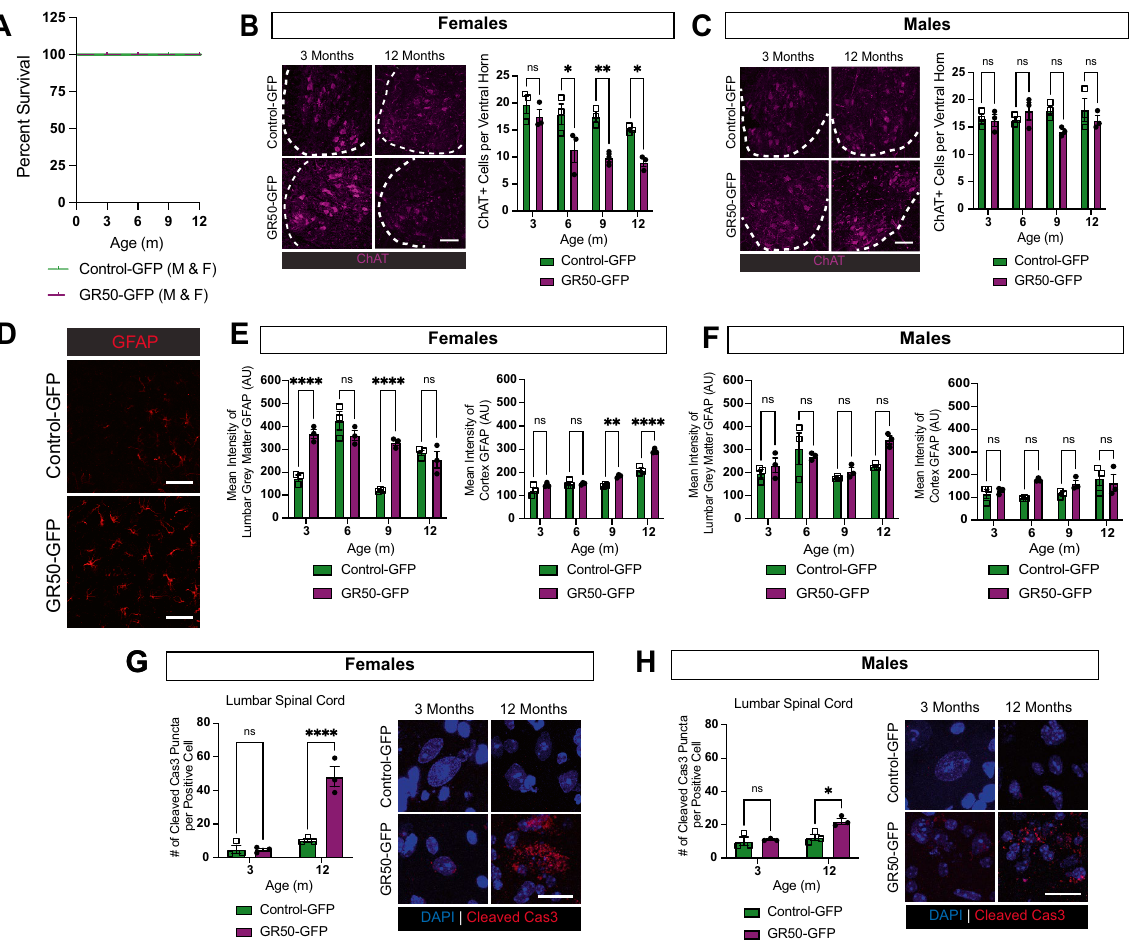
Figure 3. Histopathological changes in GR50 expressing mice. ( A ) Kaplan–Meier analysis of survival of GR50- GFP and control-GFP male and female mice over 12 months; n = 37 control-GFP mice, 29 GR50-GFP mice. ( B ) Representative image of ChAT-staining in the ventral horn of the lumbar spinal cord in female mice at 3 and 12 months. Scale bar = 100 µm. Quantification of chat-positive cells at 3-, 6-, 9- and 12-months. n = 3 mice per time-point, min. 6 fields per mouse for quantification, mean ± s.e.m. Two-way ANOVA, Sidak’s multiple comparisons test. 3-months p = 0.7329, 6-months p = 0.0163, 9-months p = 0.0051, 12-months p = 0.0269. ( C ) Same as in ( B ) but for male mice. 3-months p = 0.9997, 6-months p = 0.8340, 9-months p = 0.1198, 12-months p = 0.7119. ( D ) Representative image of GFAP fluorescence within the lumbar ventral grey matter in female control-GFP and GR50-GFP mice at 3-months-old. Scale bar = 50 µm ( E ) Quantification of lumbar ventral gray (left) and cortical GFAP expression (right) in female mice at 3-, 6-, 9- and 12-months-old. n = 3 mice per time- point, min 6 fields per mouse for quantification, mean ± s.e.m. Two-way ANOVA, Sidak’s multiple comparisons test. Female Lumbar: 3-months p < 0.0001, 6-months p = 0.2401, 9-months p < 0.0001, 12-months p = 0.8294. Female Cortex: 3-months p = 0.1654, 6-months p > 0.9999, 9-months p = 0.0059, 12-months p < 0.0001. ( F ) Same as in ( E ) but for male mice. Male Lumbar: 3-months p = 0.8662, 6-months p = 0.9017, 9-months p = 0.9442, 12-months p = 0.0551. Male Cortex: 3-months p = 0.9886, 6-months p = 0.0559, 9-months p = 0.4431, 12-months p = 0.9192. ( G ) Quantification of cleaved caspase-3 puncta accumulation within cleaved caspase-3 positive cells of the lumbar spinal cord in female control-GFP and GR50-GFP mice at 3- and 12-months-old. n = 3 mice per time-point, min 6 fields per mouse for quantification, mean ± s.e.m. Two-way ANOVA, Sidak’s multiple comparisons test. 3-months p = 0.9974, 12-months p < 0.0001. Right: representative images of cleaved caspase-3 puncta in control-GFP and GR50-GFP female lumbar spinal cord at 3- and 12-months-old. Scale bar = 20 µm. ( H ) Same as in ( G ) but for males. 3-months p = 0.9102, 12-months p = 0.0110. Right: representative images of cleaved caspase-3 puncta in control-GFP and GR50-GFP male lumbar spinal cord at 3- and 12-months-old. Scale bar = 20